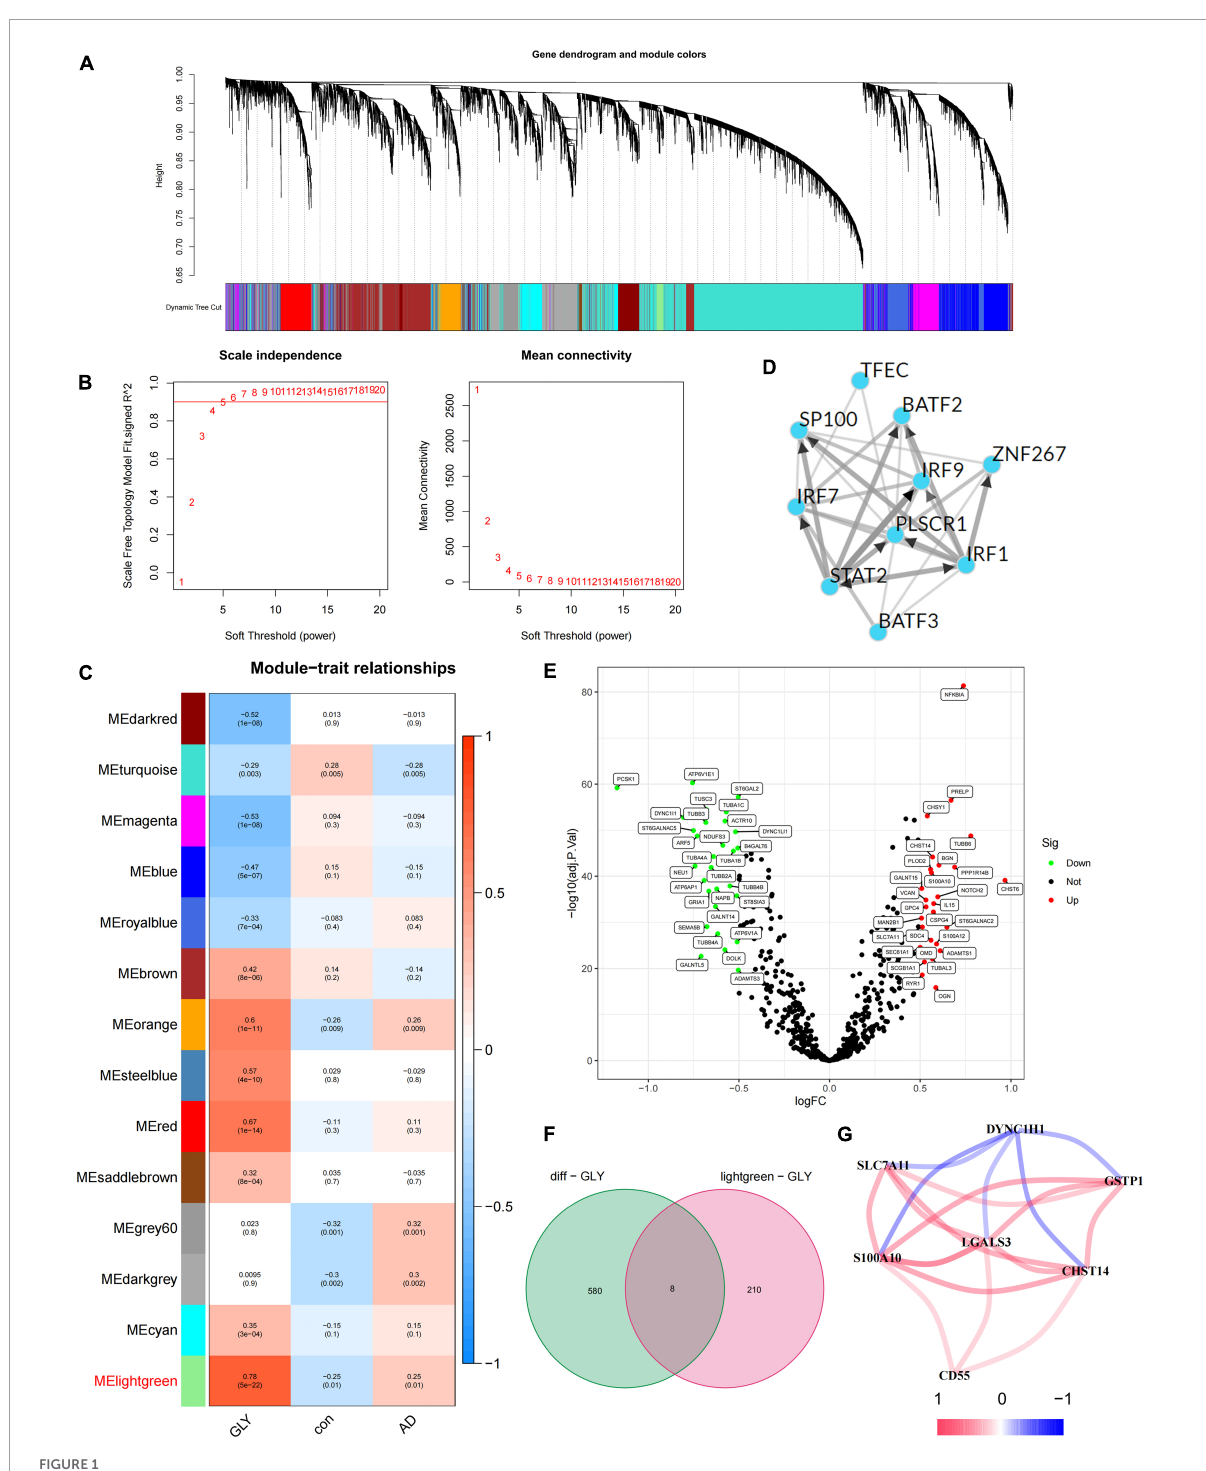
FIGURE1 Identification of core protein glycosylation-related genes (PGRGs) in Alzheimer’s disease (AD). (A) Weighted gene co-expression network analysis (WGCNA) analysis was performed on the training set, resulting in a cluster dendrogram of co-expressed genes. (B) The soft threshold of a scale-free network. (C) The module-character relationship was constructed, with each module containing the corresponding correlation and P -value. (D) Transcription factors that regulate the expression of genes are represented by the MElightgreen module and their interactions. (E) Differentially expressed PGRGs between the training set and control samples. (F) The intersection of genes represented by the differentially expressed PGRGs and MElightgreen modules between the training set and control samples. (G) The co-expression relationship of 7 core